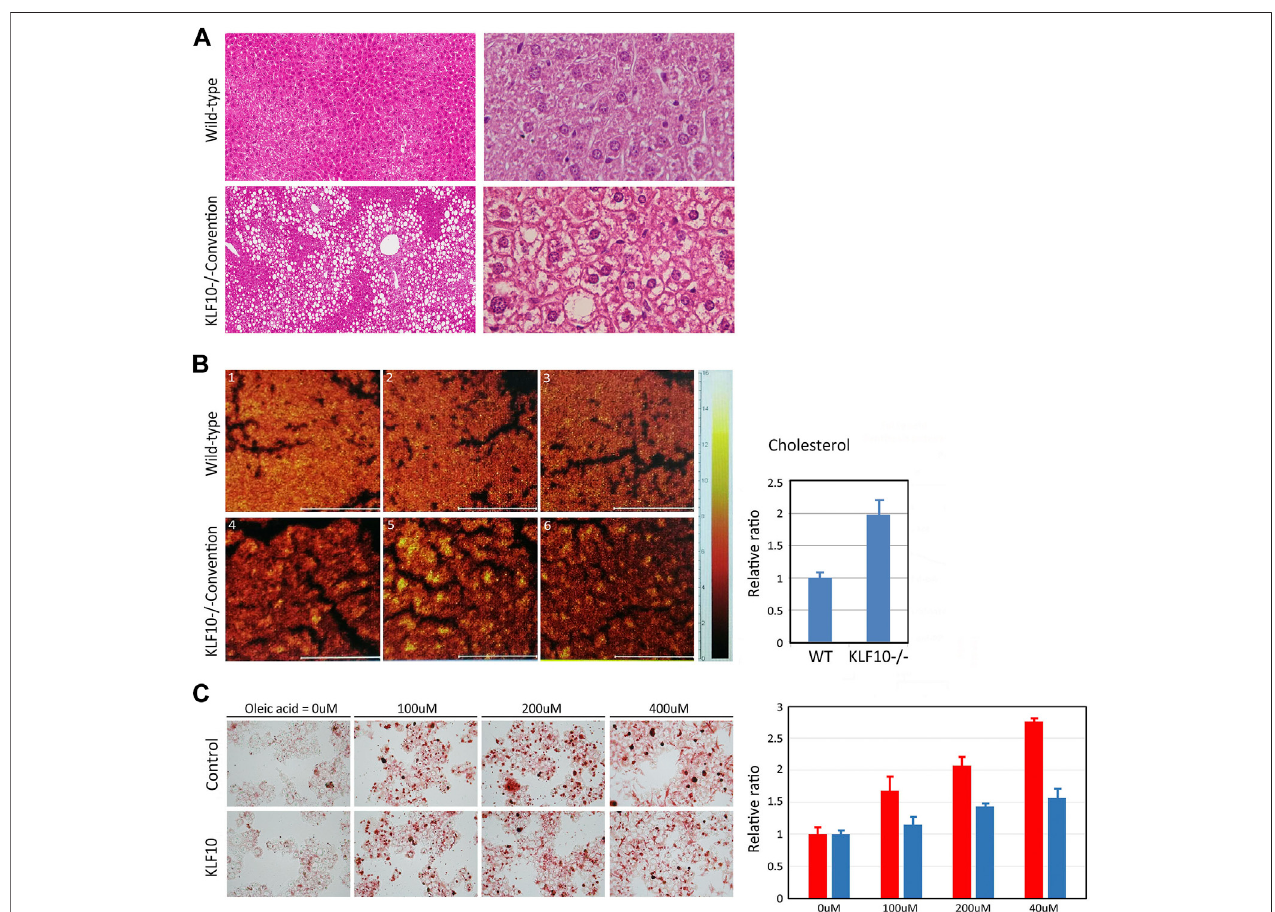
FIGURE1| KLF10de fi ciencycauses lipidaccumulation invivo and invitro . (A) Representativeliversections incontrolandKLF10-knockoutmice treatedwithHFD ( leftpanels ,100X; right panels ,400X) withHand Estain. (B) Optical micrographs withsuperimposed cholesterol mouse hepatic tissues. Theimages wereoverlaidto observethecolocalization ofcholesterol. Theright panelindicates area-normalized intensitiesofacholesterolfor standardsamplesandsubareasin tissue sections. The results represented as mean ± SD (n (cid:1) 3). (C) Lipid droplet formation was observed by oil-red-O staining in control and HepG2 cells transfected with KLF10 after treated with OA (0 – 400 mM). The quanti fi cation of triglyceride contents in cells treated with OA (right panel) in control (red column) and KLF10 overexpressed (blue column) HepG2 cells. Data represented as mean ± SD (n (cid:1)